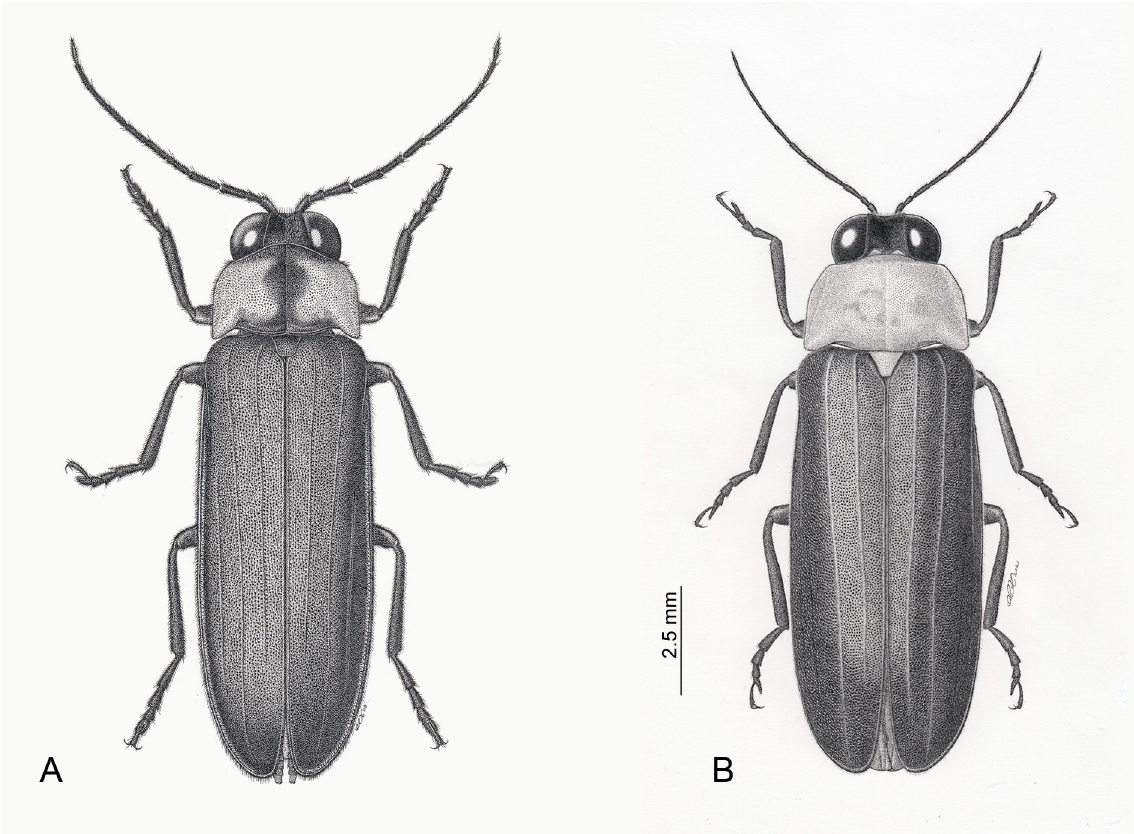
Fig. 1. Dorsal habitus males. A . Nipponoluciola cruciata (Motschulsky, 1854) gen. et comb. nov. B . Nipponoluciola owadai (Satô & Kimura, 1994) gen. et comb. nov. Drawings by I. Kawashima